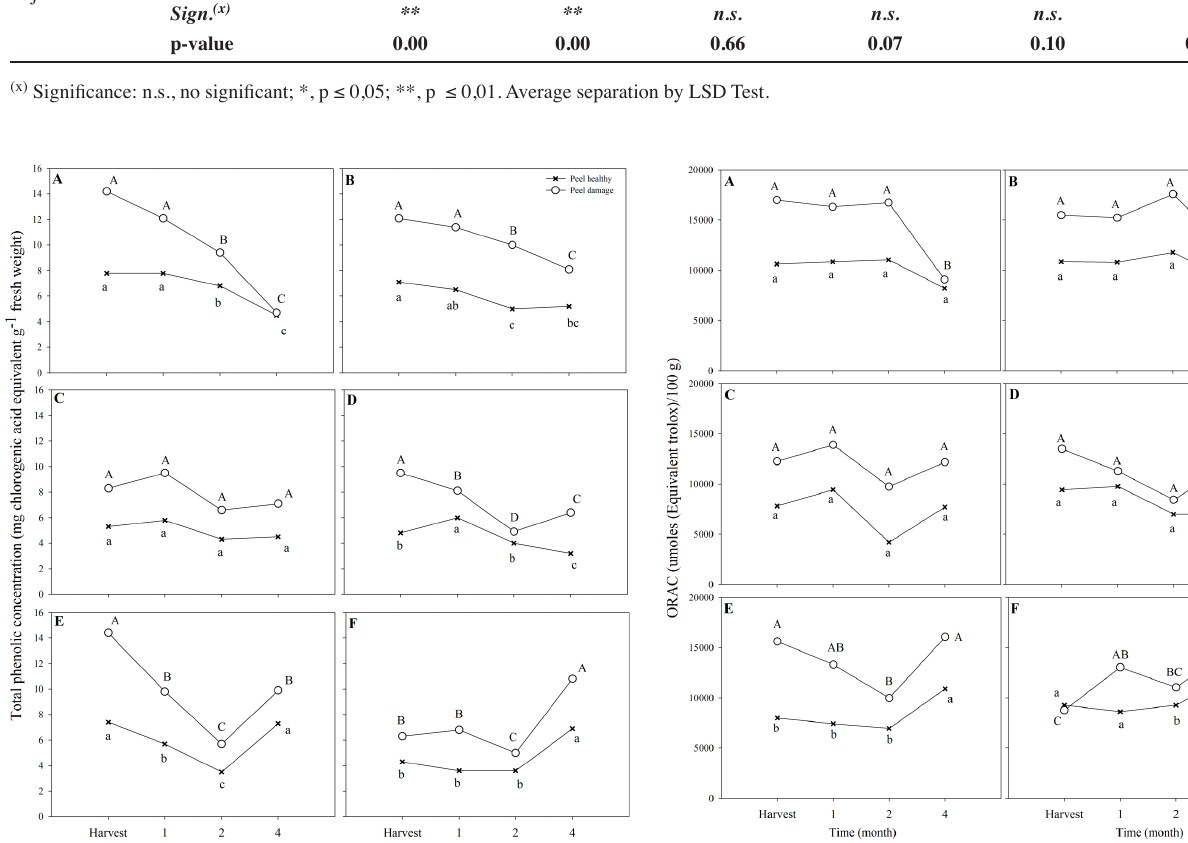
in cv. Fuji (Fig. 3). Fig. 4 and 5 show the evolution of phenolic compounds and ORAC in the flesh of OO and CO apples of the cvs. from harvest to four months of storage. In general terms, phenolic content did not vary with storage time for all three cultivars, both organic and nonorganic. Phenol content was also similar in the flesh of healthy and sunburn damaged fruit. Content values remained the same from harvest to